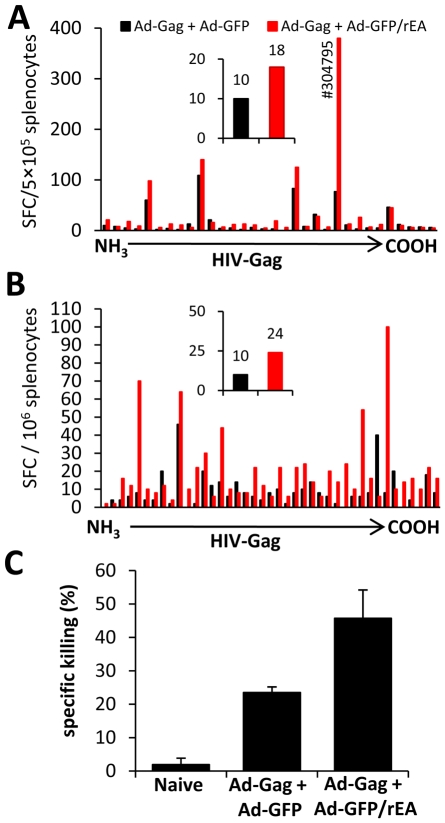
Increased quantity and quality of Gag-specific T-cells in Ad-GFP/rEA co-injected mice.At 14 dpi, splenocytes from vaccinated C57BL/6 (1×107 total vps) (A) or Balb/c (1×108 total vps) (B) mice were equivalently pooled (N = 3 mice per treatment) and individual wells were stimulated ex vivo with a pool of 2-4 15-mer peptides spanning the complete Gag protein sequence, not including peptides included in Figure 5 (AMQ, or 304796). Inset graphs indicate the number of wells with >10 SFCs. This experiment was carried out two independent times with the same result. (C) Balb/c mice were vaccinated as above (total of 1×107 vp). At 14 dpi, an in vivo CTL assay was completed and Gag specific CTL activity was quantified (N = 2 for all treatments). This experiment was carried out two independent times, each with the same result.